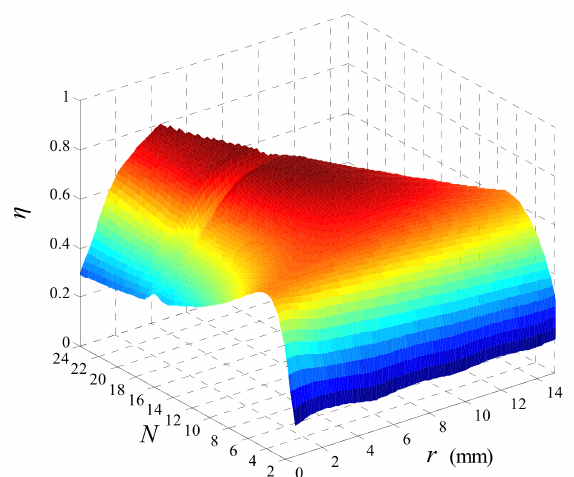
Figure 13. Results of finite element simulation.